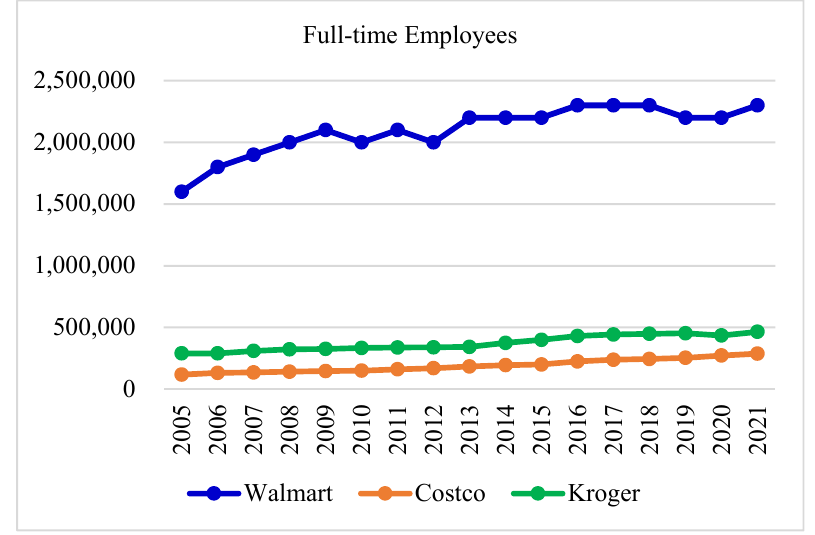
Figure 9. Full-time employees.